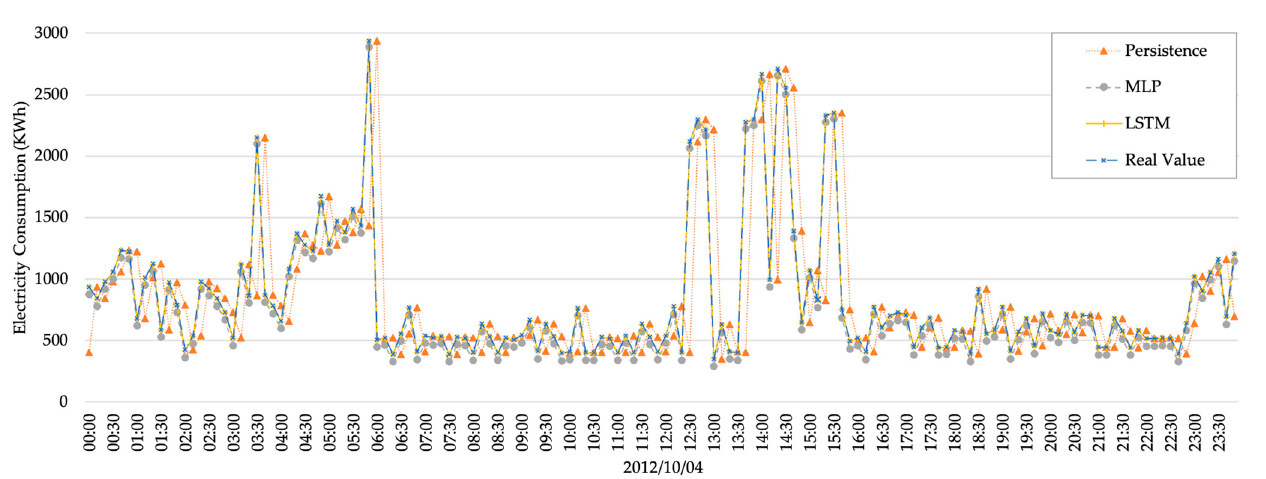
Figure 8. Examples of electricity consumption predictions of HCPF module for one day.